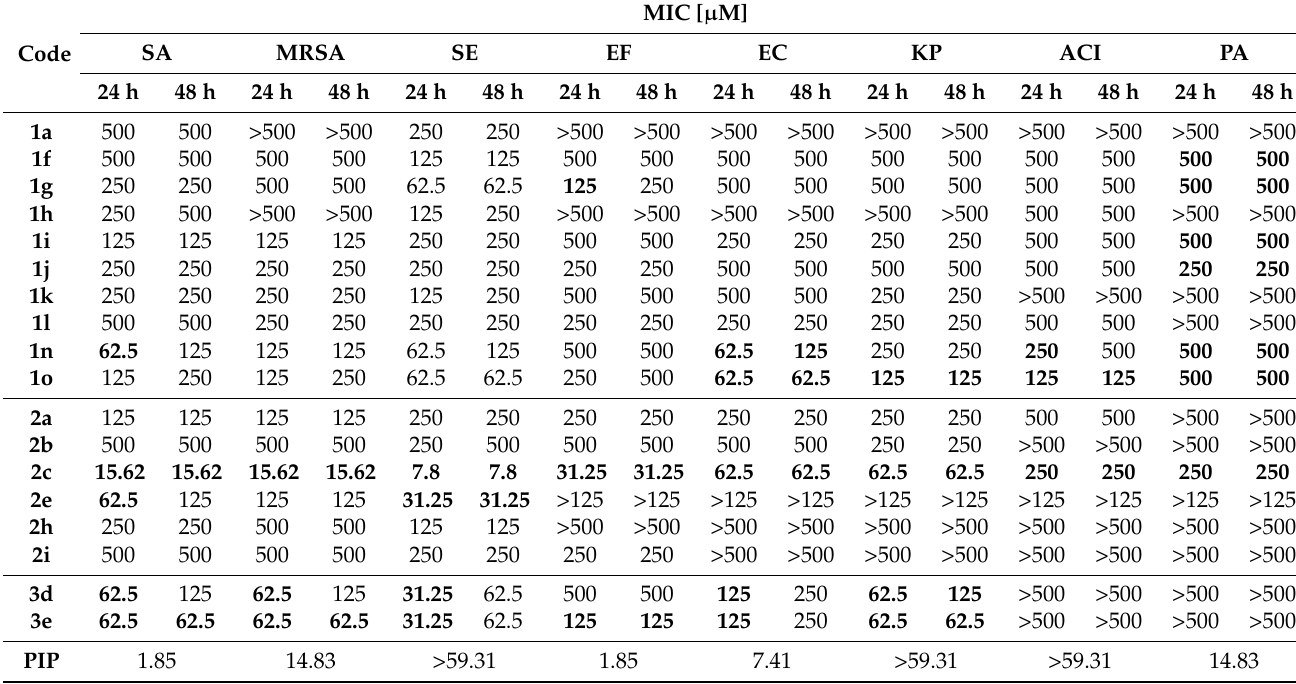
Table 1. Antibacterial activity of 1 – 3